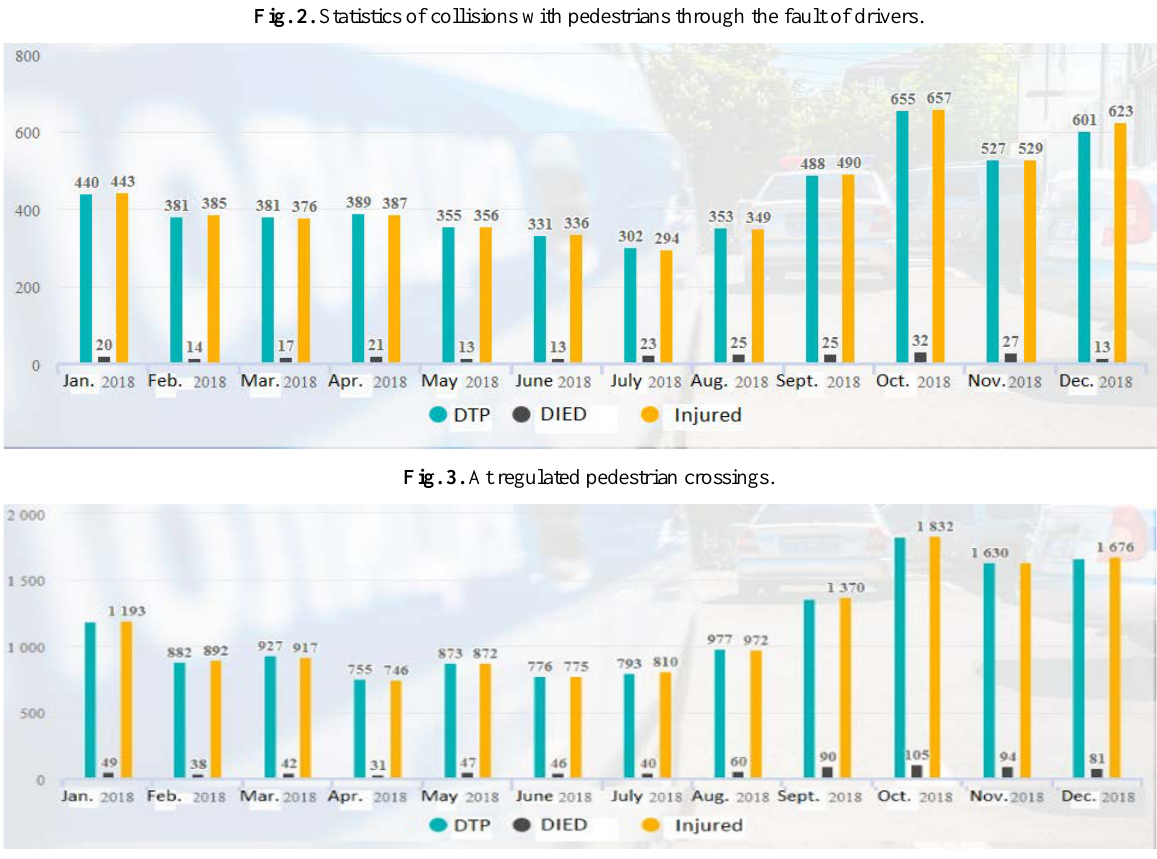
Fig. 4. At unregulated pedestrian